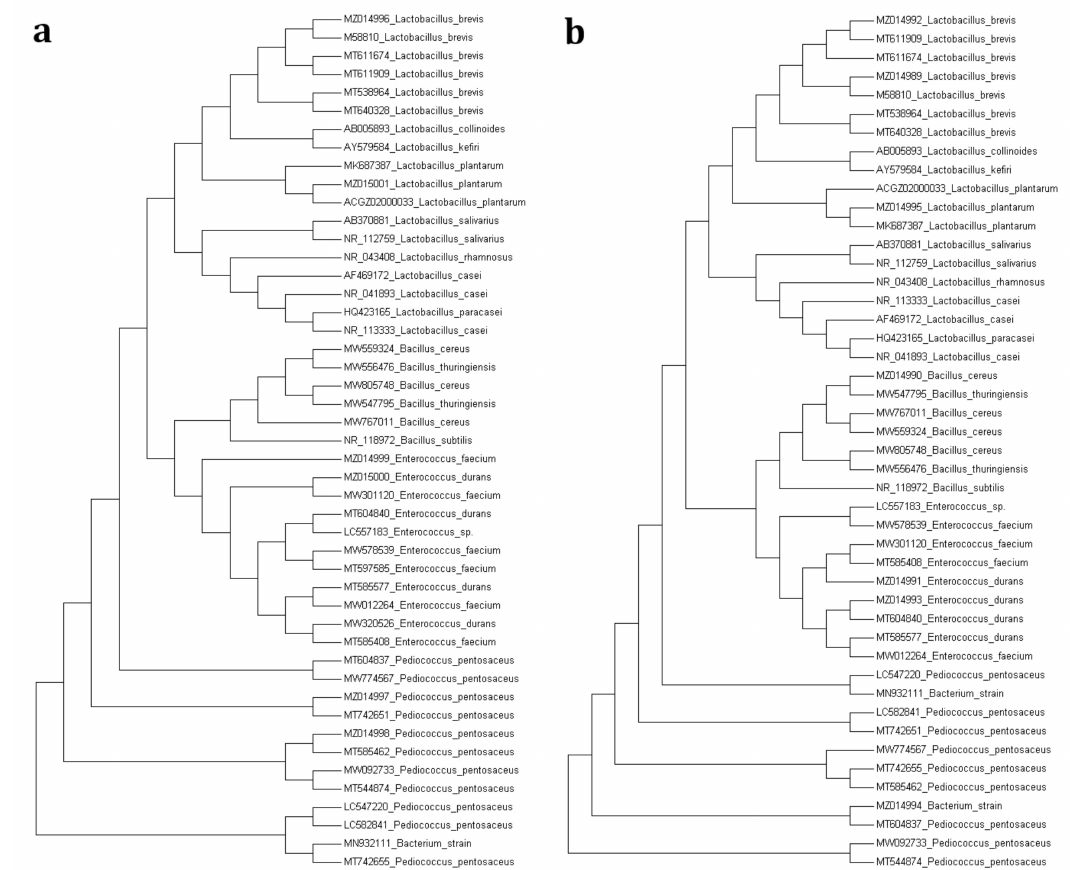
Figure 5. The phylogenic tree of the bacterial community is estimated using the NJ method (Kimura 2) that retrieved sequences provided by the NCBI GenBank database (MZ014989- MZ015001 from this study) (https://www.ncbi.nlm.nih. gov/, accessed on 12 April 2021). ( a ) comparison of sequences that retrieved from NCBI GenBank database and commercial kefir, ( b ) comparison of sequences that retrieved from NCBI GenBank database and homemade